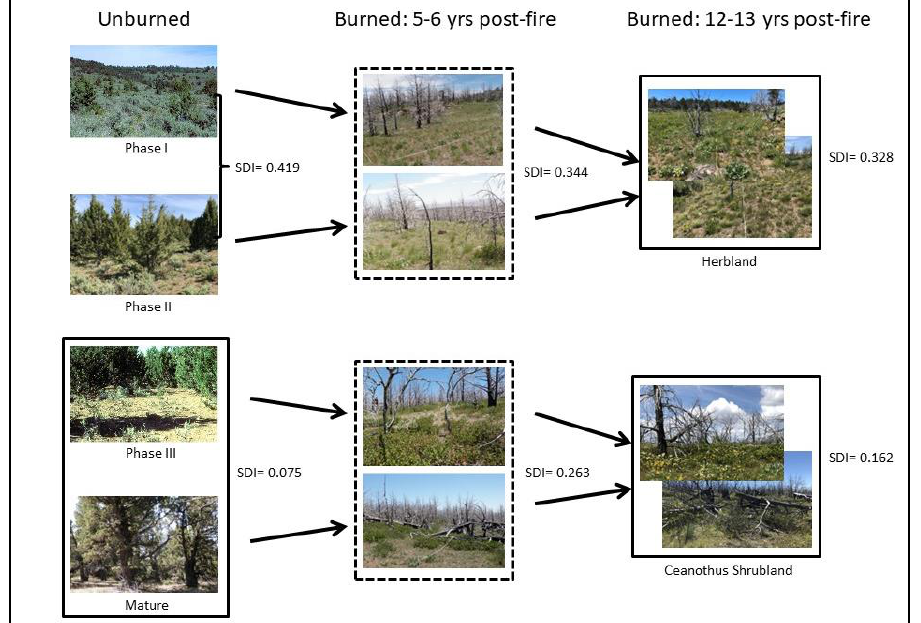
Figure 8. Proposed post-fire successional pathways as influenced by pre-fire plant community composition and structure. Early successional stages (Phase I and II) result in a herb-dominated community 12 – 13 following fire. Sorensen’s Dissimilarity Index (SDI) indicates dissimilarity between phases and ranges from 0 to 1, where 0 means the plots are identical, and 1 means no similarity (complete dissimilarity). Pre-fire, plant communities of Phase I and II plots are somewhat similar (SDI = 0.419), while Phase III and Mature plots are very similar (SDI = 0.075). Following fire, burned Phase I and II plots become more similar (SDI = 0.344 after 5 – 6 years, and SDI = 0.328 after 12 – 13 years). Burned Phase III and Mature plots also stay similar as succession progresses (SDI = 0.263 after 5 – 6 years, and SDI = 0.162 after 12 – 13 years). The dashed-line box indicates that the communities within the box are not significantly different from each other in spite of being initially different pre-fire.